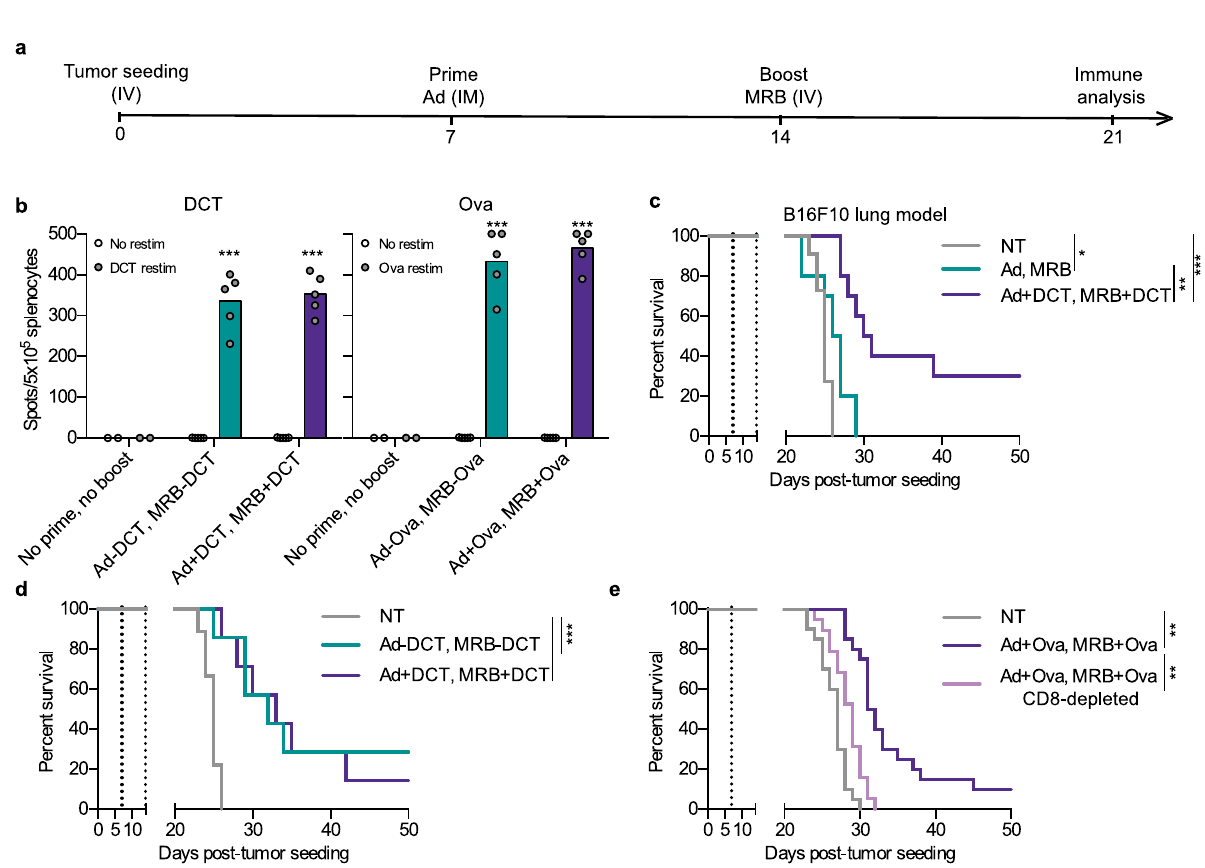
Fig. 3 Adjuvant OV boost vaccination generates memory CD8 T cells. a Treatment schedule used in this study. b Flow cytometry analysis of splenocytes and blood cells from tumor-free mice primed with Ad-Ova and boosted or not with MRB co-administered with Ova peptide 7 days later. Blood samples were collected on days 14, 28 and 35 and splenocytes were also analyzed on day 35. The bar charts show the percentage of Ova-tetramer + cells (within the CD8 + live cell population) (top panel) or of live cells that are CD8 + , Ova-tetramer + (bottom panel) ( n = 2 (no prime, no boost) and 3 (Ad-Ova, no boost and Ad-Ova, MRB + Ova)). c Contour plots showing CD44 expression and IFN γ or TNF α production by CD8 + splenocytes (day 35) re-stimulated ex-vivo with Ova peptides. d Quanti fi cation of the percentage of CD8 + cells that are CD44 + , IFN γ + or CD44 + , TNF α + with and without ex-vivo re- stimulation n = 2 (no prime, no boost) and 3 (Ad-Ova, no boost and Ad-Ova, MRB + Ova). e Contour plots showing the expression of KLRG1 and CD127 by Ova-tetramer + CD8 T cells. The graphs also delineate different T cell subpopulations: memory precursor effector cells (MPECs), double-positive effector cells (DPECs), short-lived effector cells (SLECs) and early effector cells (EECs) ( n = 2 (no prime, no boost) and 3 (Ad-Ova, no boost and Ad-Ova, MRB + Ova)). f Quanti fi cation of the populations identi fi ed in ( e ) for all mice ( n = 3). Data are presented as mean values ± SEM. g Absolute number of MPECs, DPECs, SLECs and EECs from the spleen of the mice at day 35 ( n = 3). Data are presented as mean values ± SEM. h Representative contour plots showing different T cell populations based on CD44 and CD62L expression of splenocytes from untreated animals (left panel) or of CD8 + , Ova-tetramer + cells from the blood and the spleen of both treatment groups at day 35 (right panels). The graphs also show the gating strategy used to distinguish between naïve, central memory (CM), effector memory (EM) and double negative (DN) CD8 + T cells ( n = 2 (no prime, no boost) and 3 (Ad-Ova, no boost and Ad- Ova, MRB + Ova)). i Quanti fi cation of the populations identi fi ed in ( g ) for all mice at different time points (top panel) and absolute number of naive, CM, EM and DN CD8 + , Ova-tetramer + cells from the spleen of mice at day 35 (bottom panel) ( n = 3). Data are presented as mean values± SEM. Unless indicated otherwise, the statistical analyses refer to the comparison between the corresponding ex-vivo “ No restim ” and “ restim ” conditions. NS: p > 0.05, *: p < 0.05, **: p < 0.01, ***: p < 0.001 (unpaired two-tailed t -test). Source data are provided as a Source Data fi le. Exact p values can be found in the Source Data.